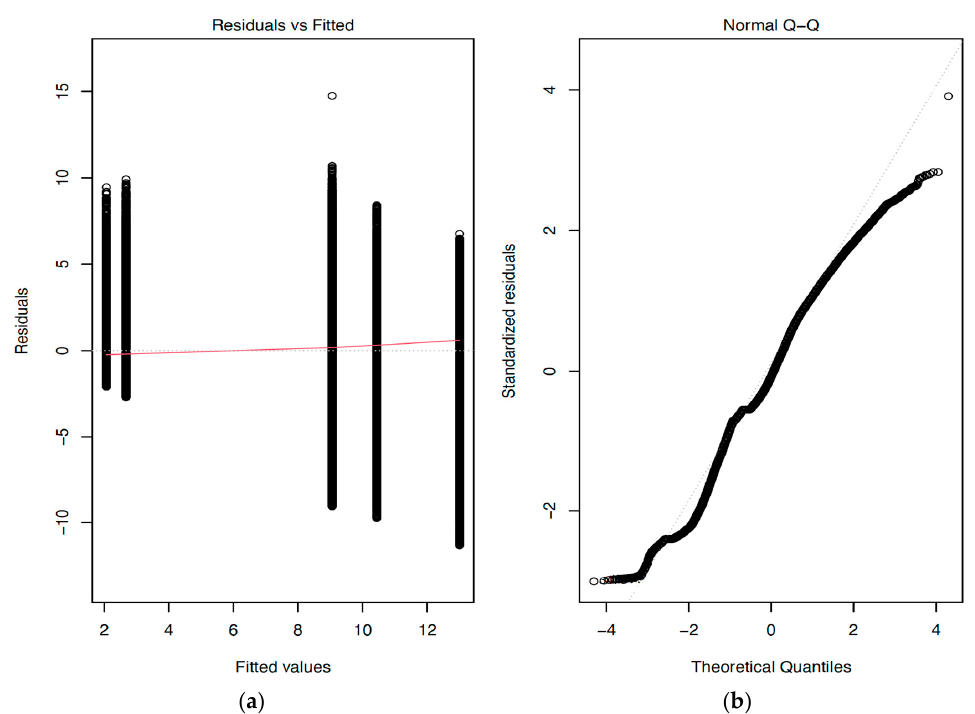
Figure A1. ( a ) Distribution of energy at di ff erent sun level. ( b ) Distribution of energy at di ff erent plots.